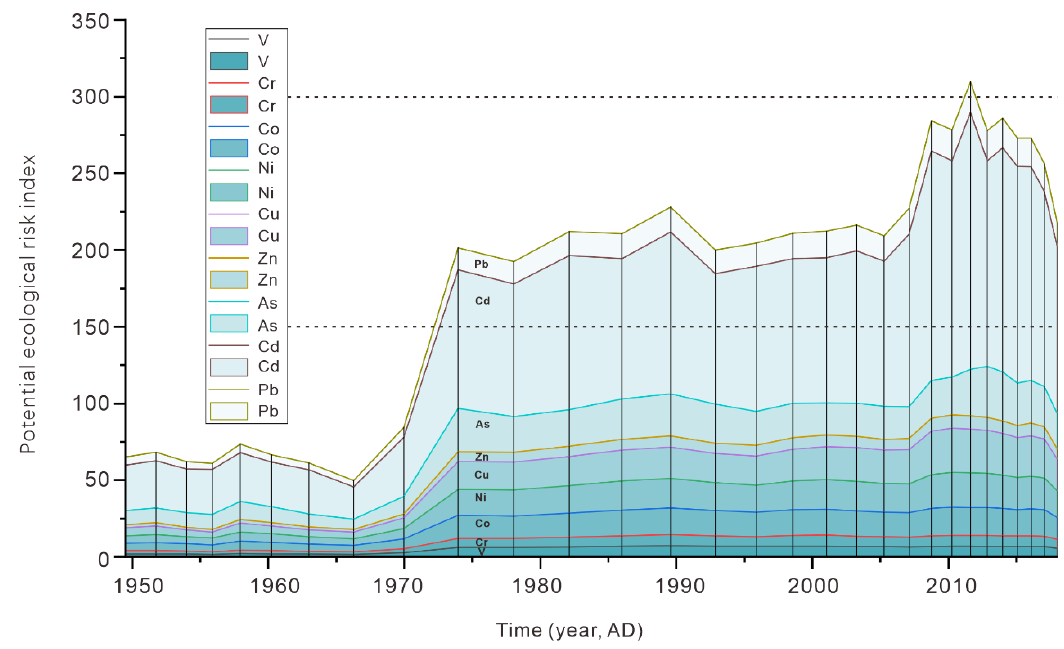
Figure 7. Stacked area chart shows how the PTEs have collectively changed over the past ca. 70 years.